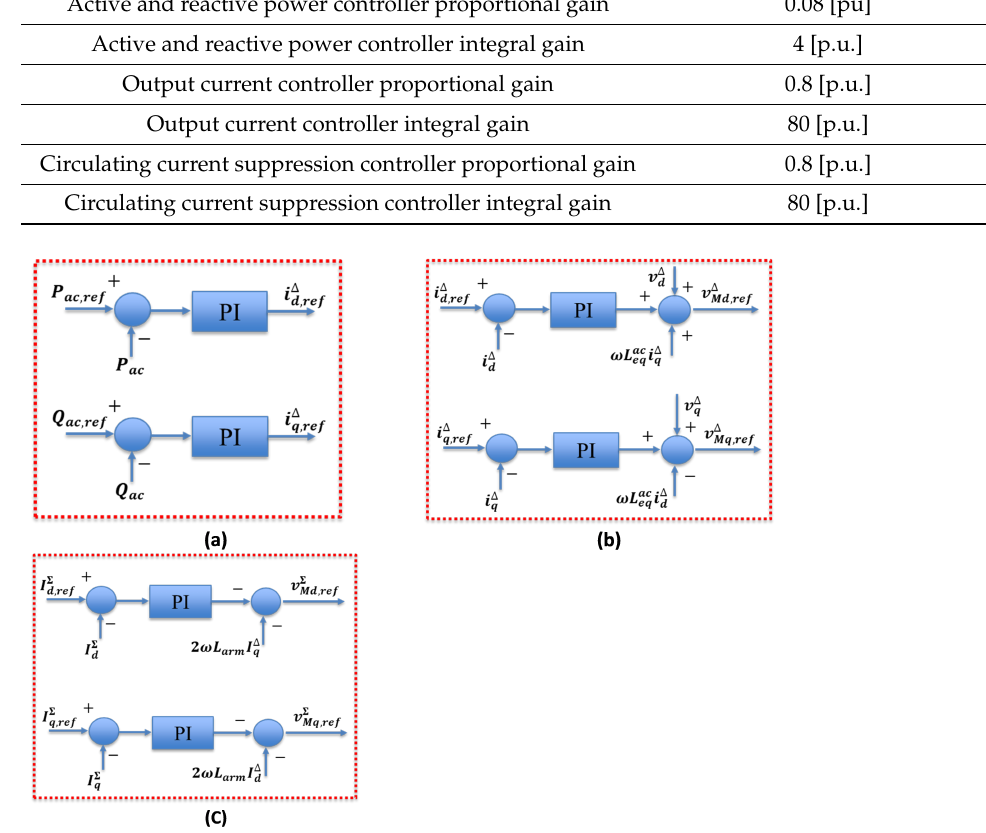
Figure 4. Implemented controlling loops for: ( a ) active and reactive power control; ( b ) output current control; and ( c ) circulating current